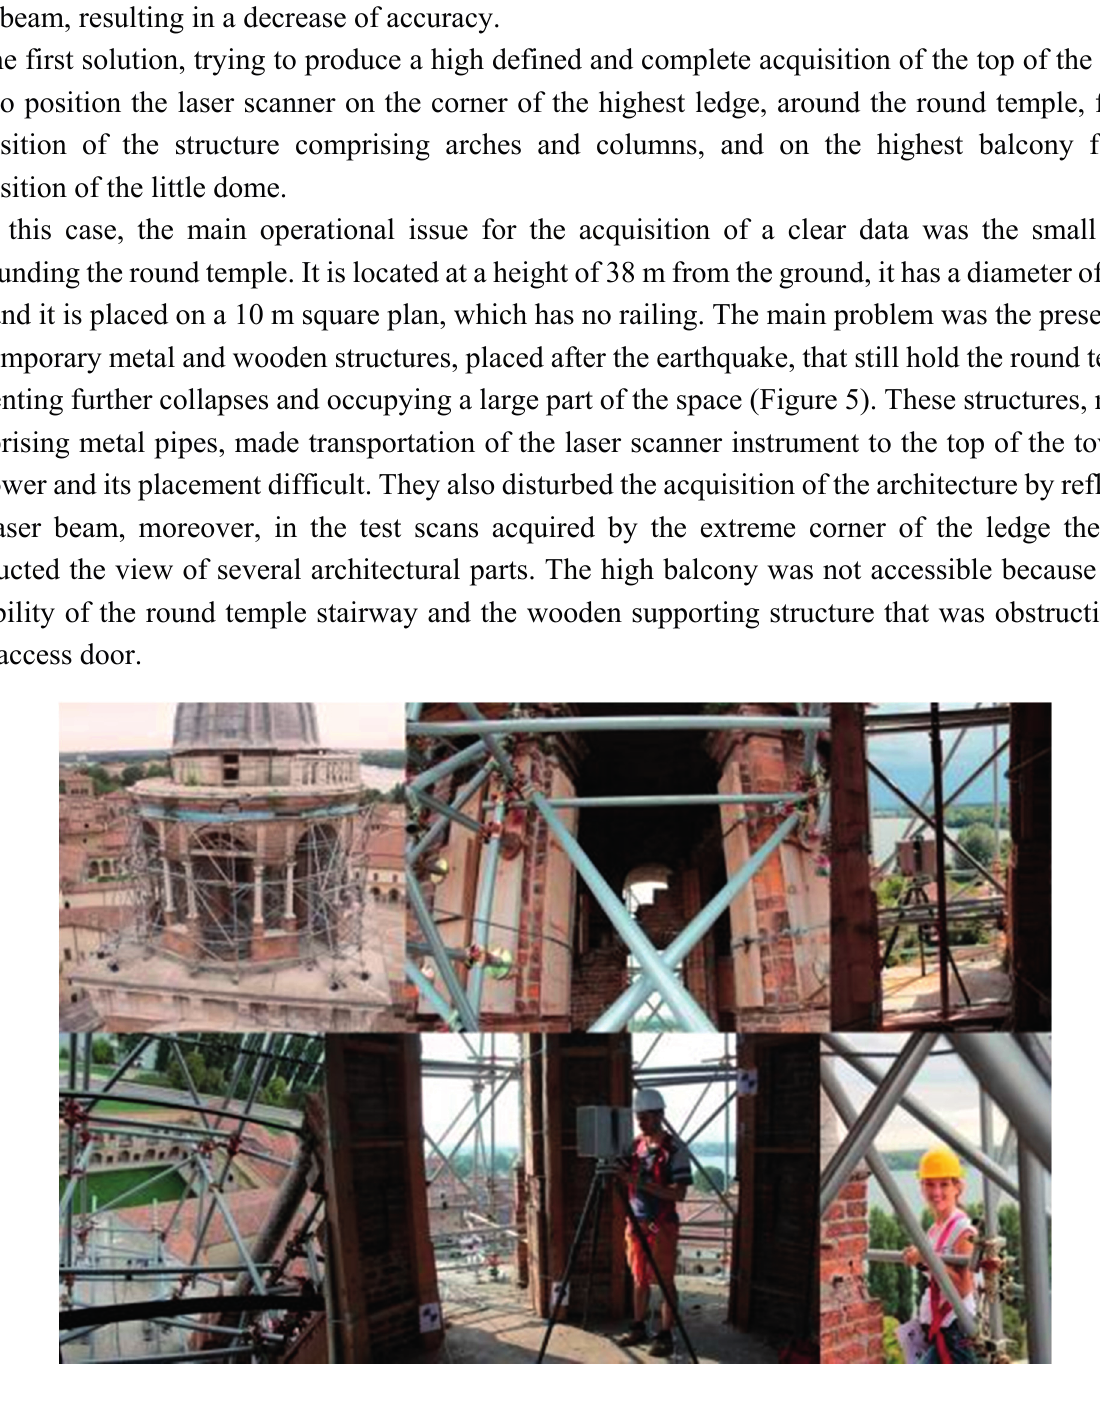
Figure 5. Some pictures of survey moments of the “round temple”, on the top of the tower. The images shows the difficulties given by the presence of the metal scaffoldings and the wooden holding structure positioned after the